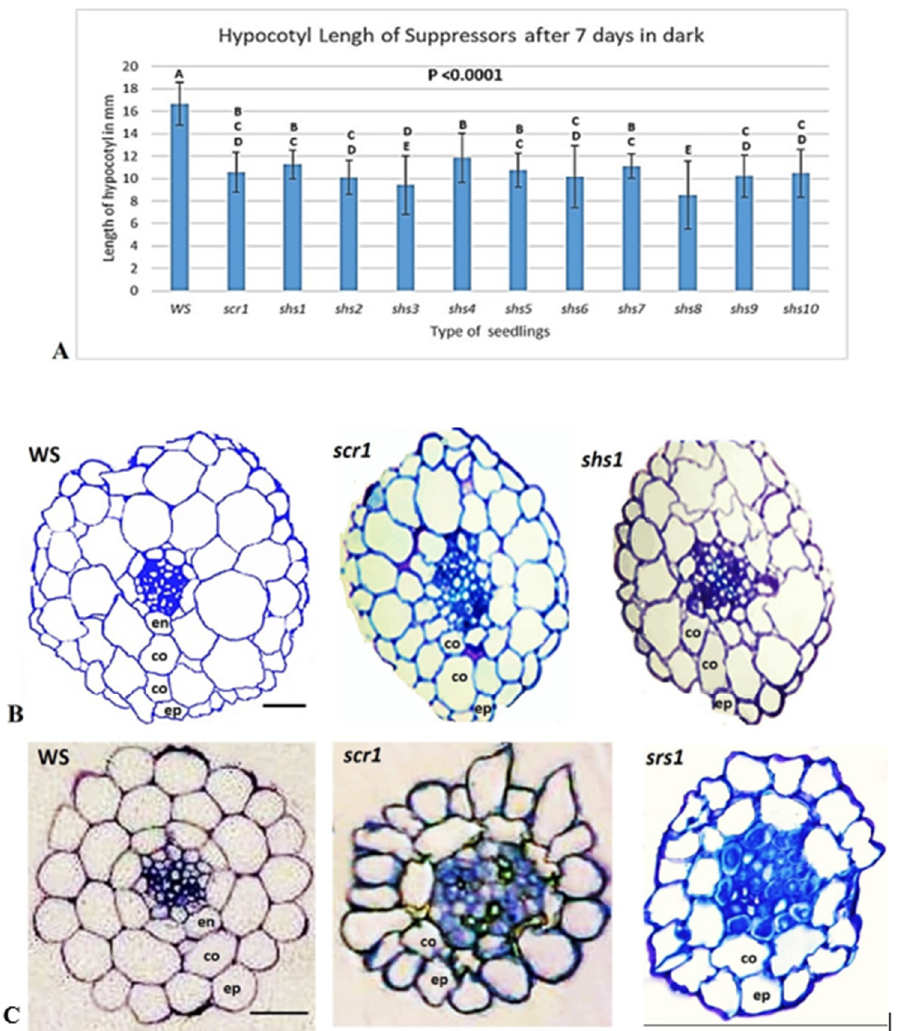
Figure 5. Phenotypic characterization of A. thaliana suppressors ( A ) Hypocotyl lengths. Seedlings of hypocotyl gravitropic suppressors shs1 to shs10 , along with wildtype (WS) and scr1 were grown in dark for seven days after germination. Length of hypocotyls was measured in mm. The X-axis represents the type of seedling (genotype), and Y-axis represents the length in mm. Error bars represent the means ± standard deviation (SD). The lack of shared letters on the bars indicates a significant difference. To determine the significant differences between wild type and mutant treatments, we used ANOVA followed by Fisher’s test. ( B ) Cross-section of WS, scr1 , and shs1 hypocotyls. Seedlings were grown in dark for three days after germination. WS has endodermis followed by two ground tissue layers (two cortex), and epidermis. The endodermal layer is missing in both scr1 and shs1 . Scale bar, 50 µ m. ( C ) Cross-section of WS, scr1 , and srs1 roots. WS has endodermis followed by one ground tissue layer (cortex), and epidermis. The abnormal radial pattern displayed by scr1 and srs1 roots is shown. en, endodermis; co, cortex; ep, epidermis. Scale bar, 50 µ m.